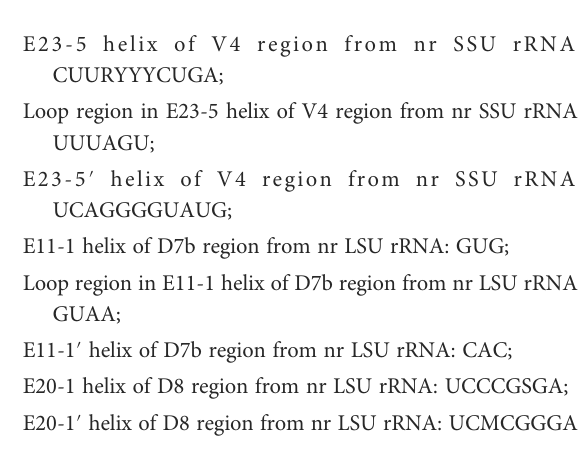
HOLOTYPE: NNIBRPR 25451, stomatocyst on an SEM stub National Institute of Biological Resources, Sangju, Korea